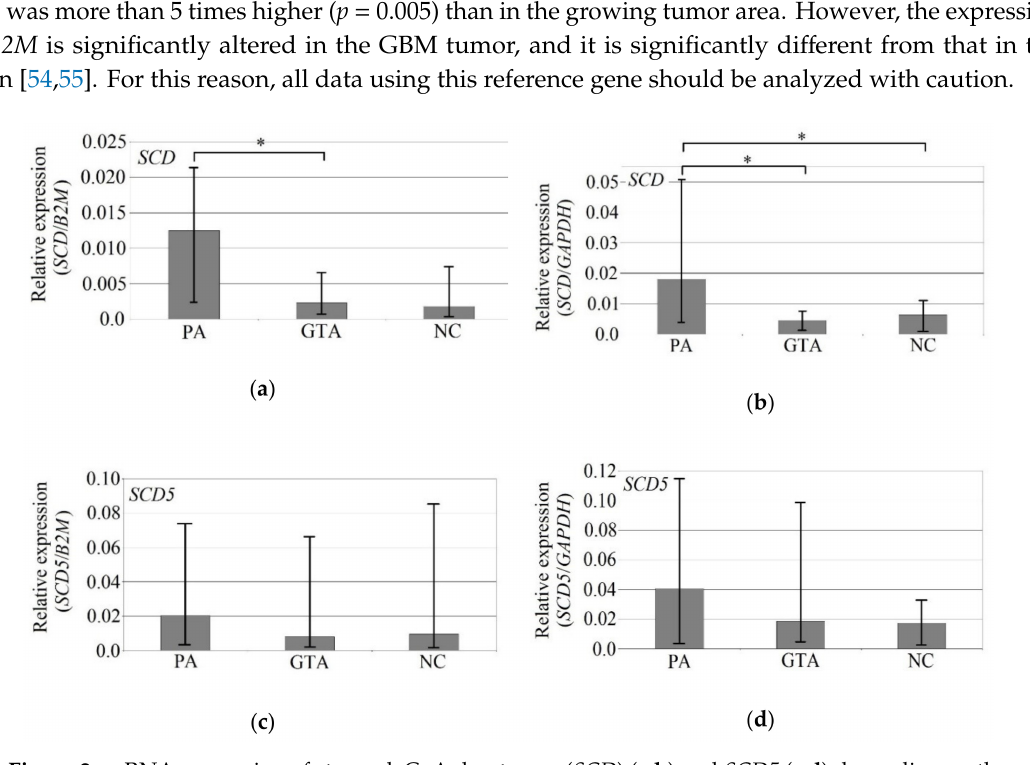
Figure 2. mRNA expression of stearoyl–CoA desaturase ( SCD ) ( a , b ) and SCD5 ( c , d ) depending on the location in GBM, using B2M and GAPDH genes as reference. The graphs show the median mRNA expression of a given desaturase. The error bars are the first and third quartiles. *—statistically significant di ff erence in the expression of a given desaturase between the tumor area according to the Wilcoxon signed-rank test ( p < 0.05). PA—peritumoral area (n = 22); GTA—growing tumor area (n = 19); NC—necrotic core (n =